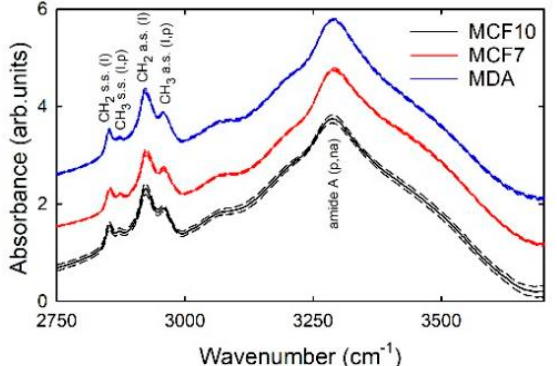
Figure 1. Mean FTIR spectra of MCF10A (continuous black line), MCF7 (continuous red line), and MDA (continuous blue line) cells after SNV normalization. Standard deviation spectra are also reported as dashed lines. The assignment of vibrational modes is also reported (c: carbohydrates; n.a.: nucleic acids; p: proteins; l: lipids). The spectra are vertically shifted for clarity of purpose.